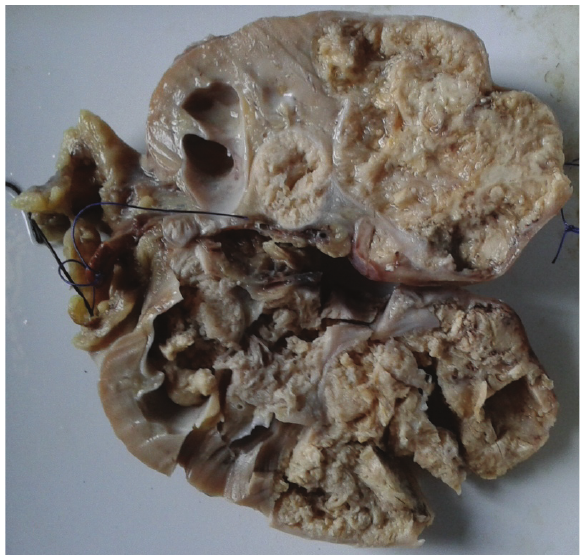
Figure 1. Gross specimen of kidney revealing a large firm yellow mass with multiple foci of